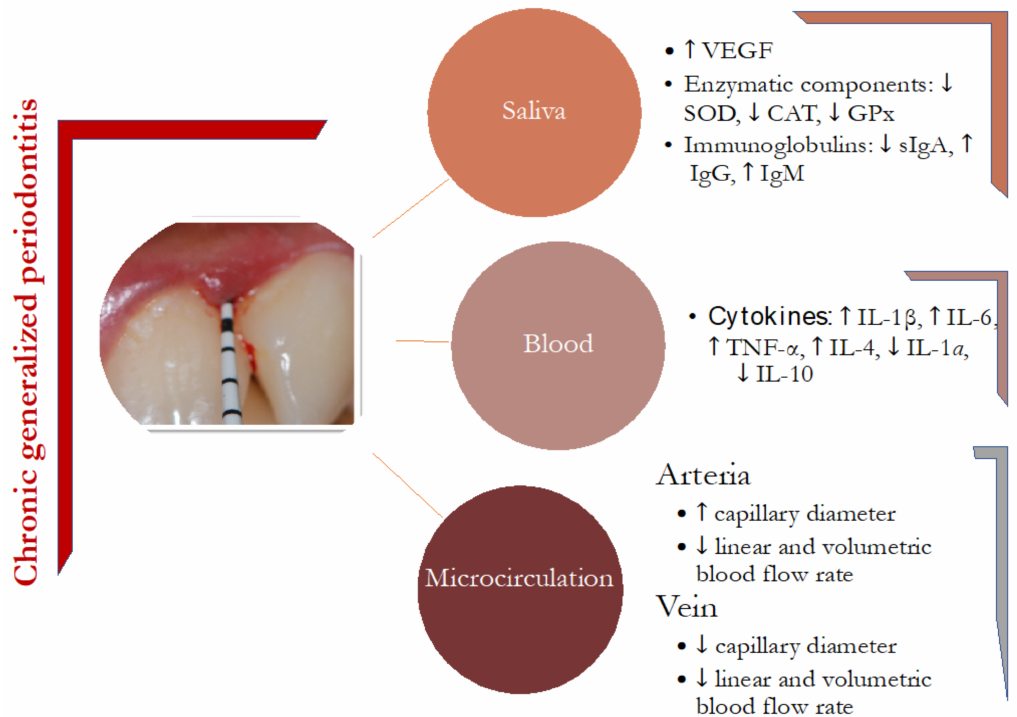
Figure 2. Characterization of observed changes in microcirculation, blood and saliva in chronic generalized periodontitis subject. GPx: glutathione peroxidase; Ig: immunoglobulin; IL: interleukin; CAT: catalase; SOD: superoxide dismutase;